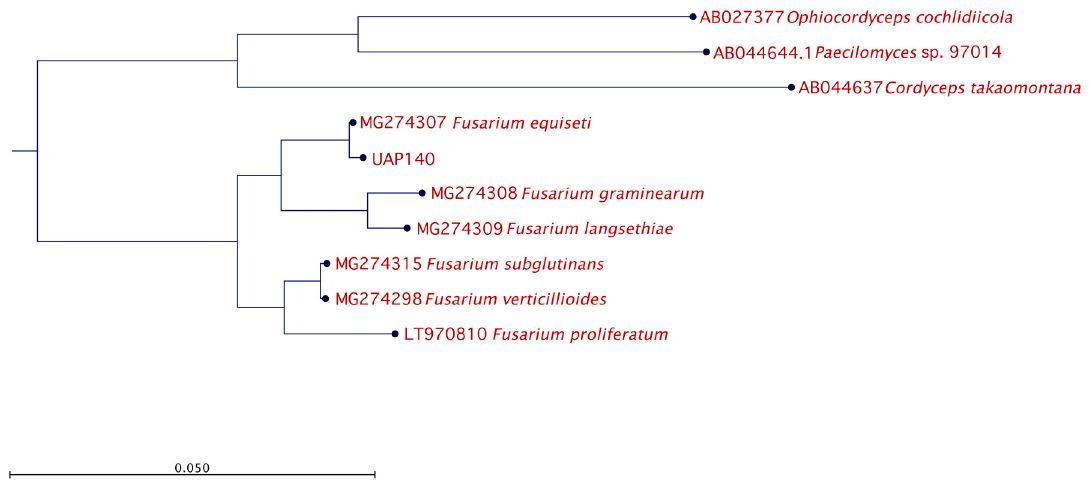
Figure 5. Phylogenetic relationship for isolate UAP140. The tree with the highest log likelihood is shown. The tree is drawn to scale, with branch lengths measured in the number of substitutions per site. The analysis involved six Fusarium reference nucleotide sequences with a total of 100 replicates in the bootstrap analysis, while three non-related fungal species were used as the outgroup.